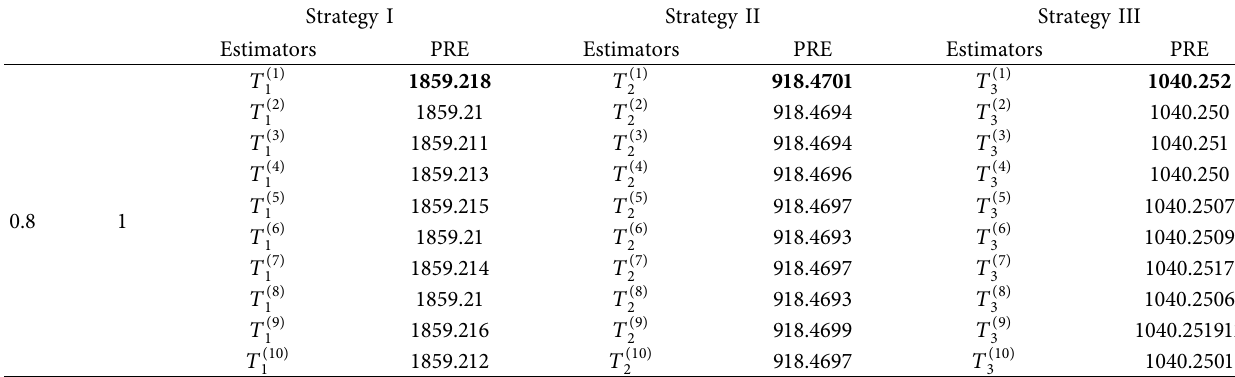
Table 9: PRE of the existing and proposed class of estimators of Population-III at ρ ∗